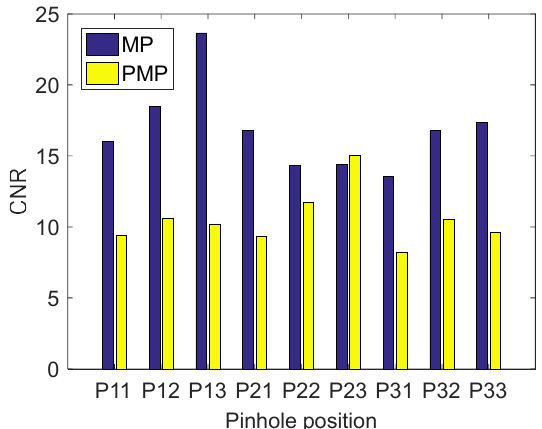
Figure 8. ( a ) Projection and ( b ) reconstructed images for single pinholes of MP geometry.